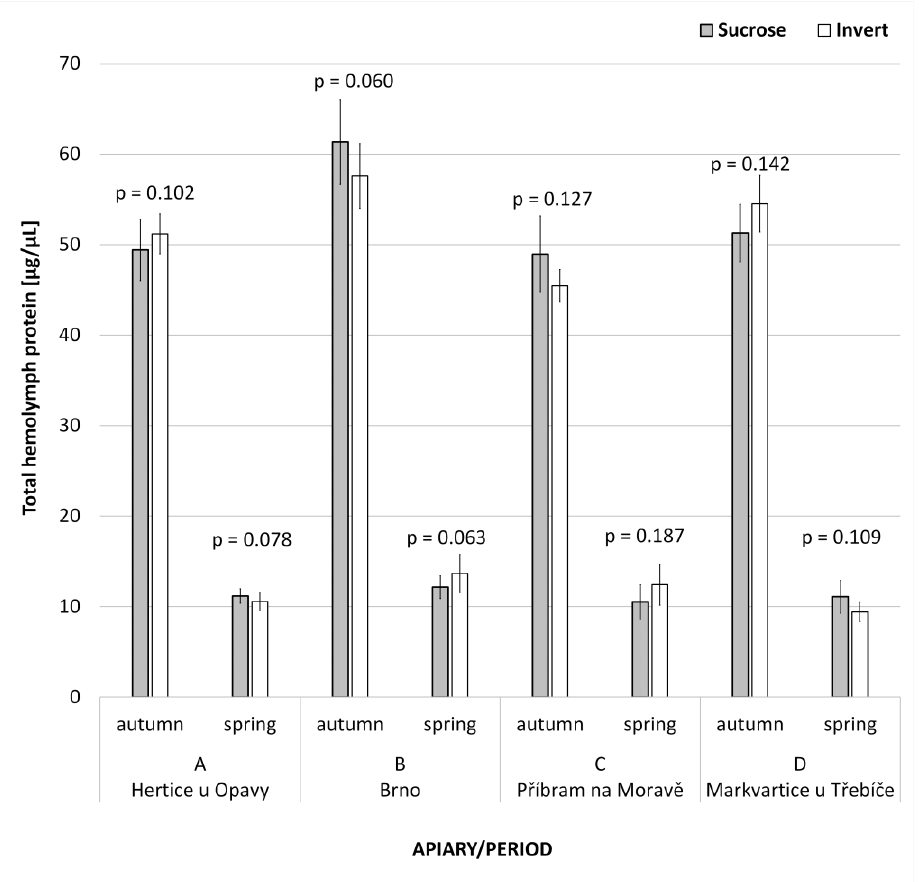
Figure 2. Total worker hemolymph protein (mean ± SD) in dependence of the type of supplemental feed, sorted according to season and location. The differences are, from a physiological point of view, small and statistically insignificant ( p > 0.05, t -test), thus, no effect of the invert syrup was proved.